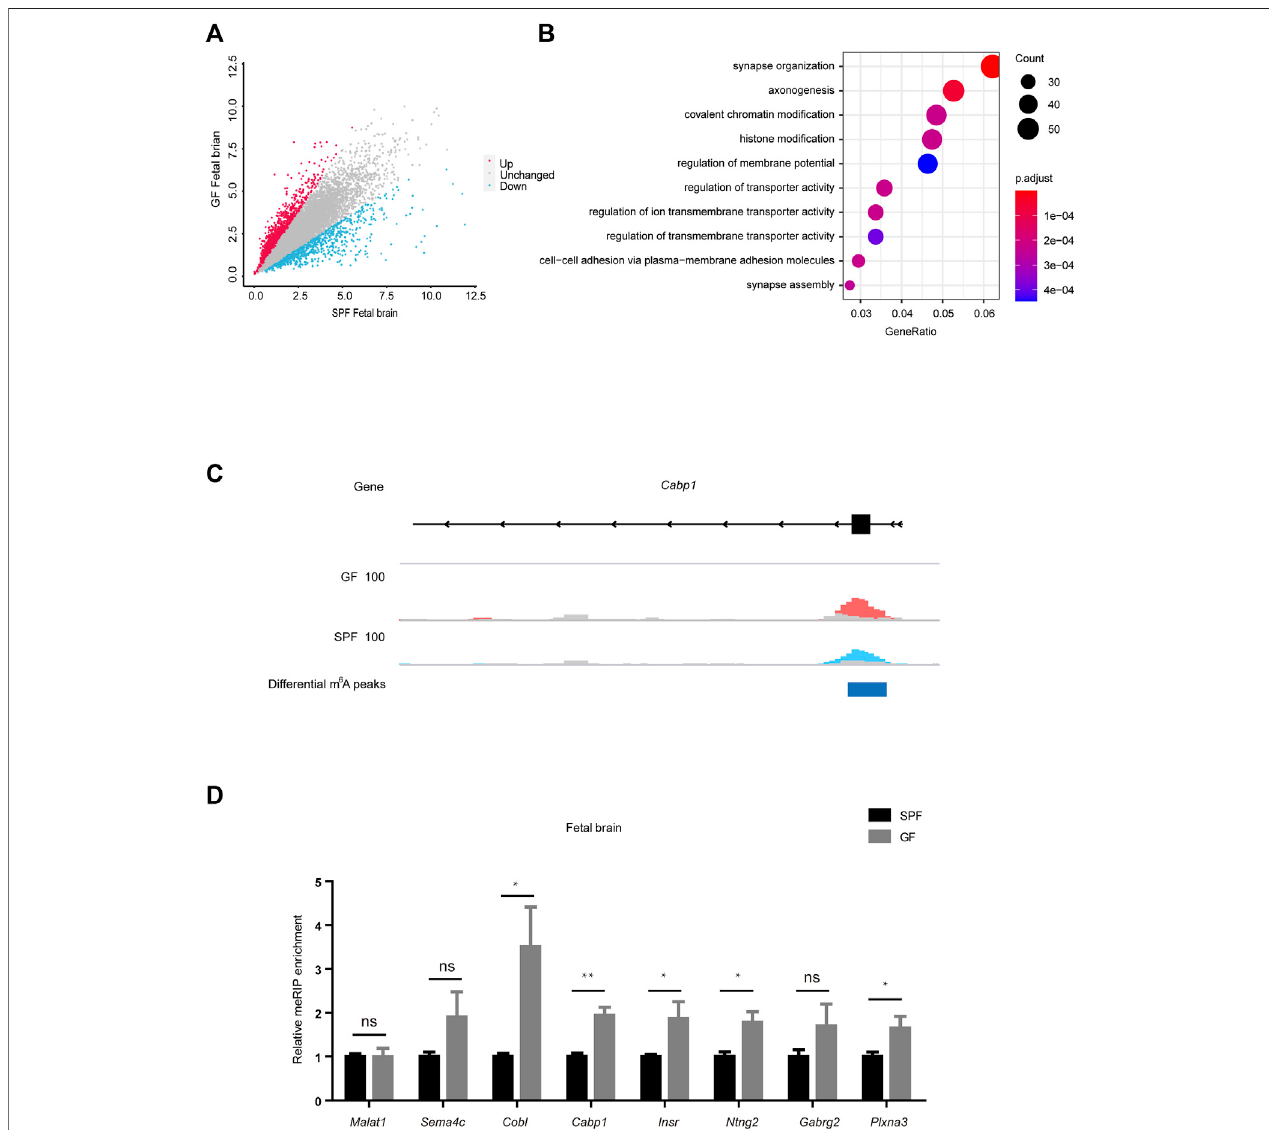
FIGURE3| Maternalmicrobiomeregulatesthem 6 Aofneurodevelopmentgenesinthemousefetalbrain. (A) Scatterdiagramshowsthenumberofdifferentialm 6 A peaks in the GF fetal brain. (B) Gene ontology-enrichment analysis of genes containing upregulated m 6 A peaks in the GF fetal brain. (C) Integrated genome viewer (IGV) shows the distribution of representative differential m 6 A peaks in Cabp1 . GF IP, SPF IP, and input are shown in red, blue, and gray, respectively. (D) Validation of the relative m 6 A enrichments of Sema4c , Cobl , Cabp1 , Insr , Ntng2 , Gabrg2 , and Plxna3 in SPF and GF fetal brains by m 6 A-immunoprecipitation (IP)-qPCR.